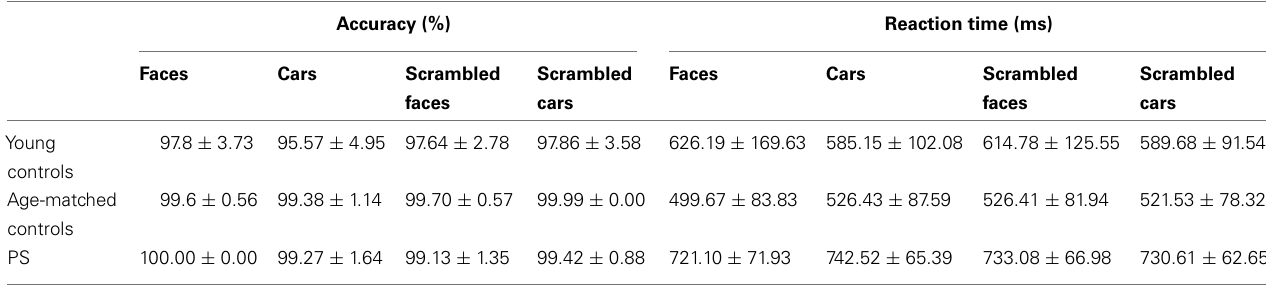
TableA1 | Mean accuracy and response time achieved by each experimental group in Experiment 1, faces vs. objects.